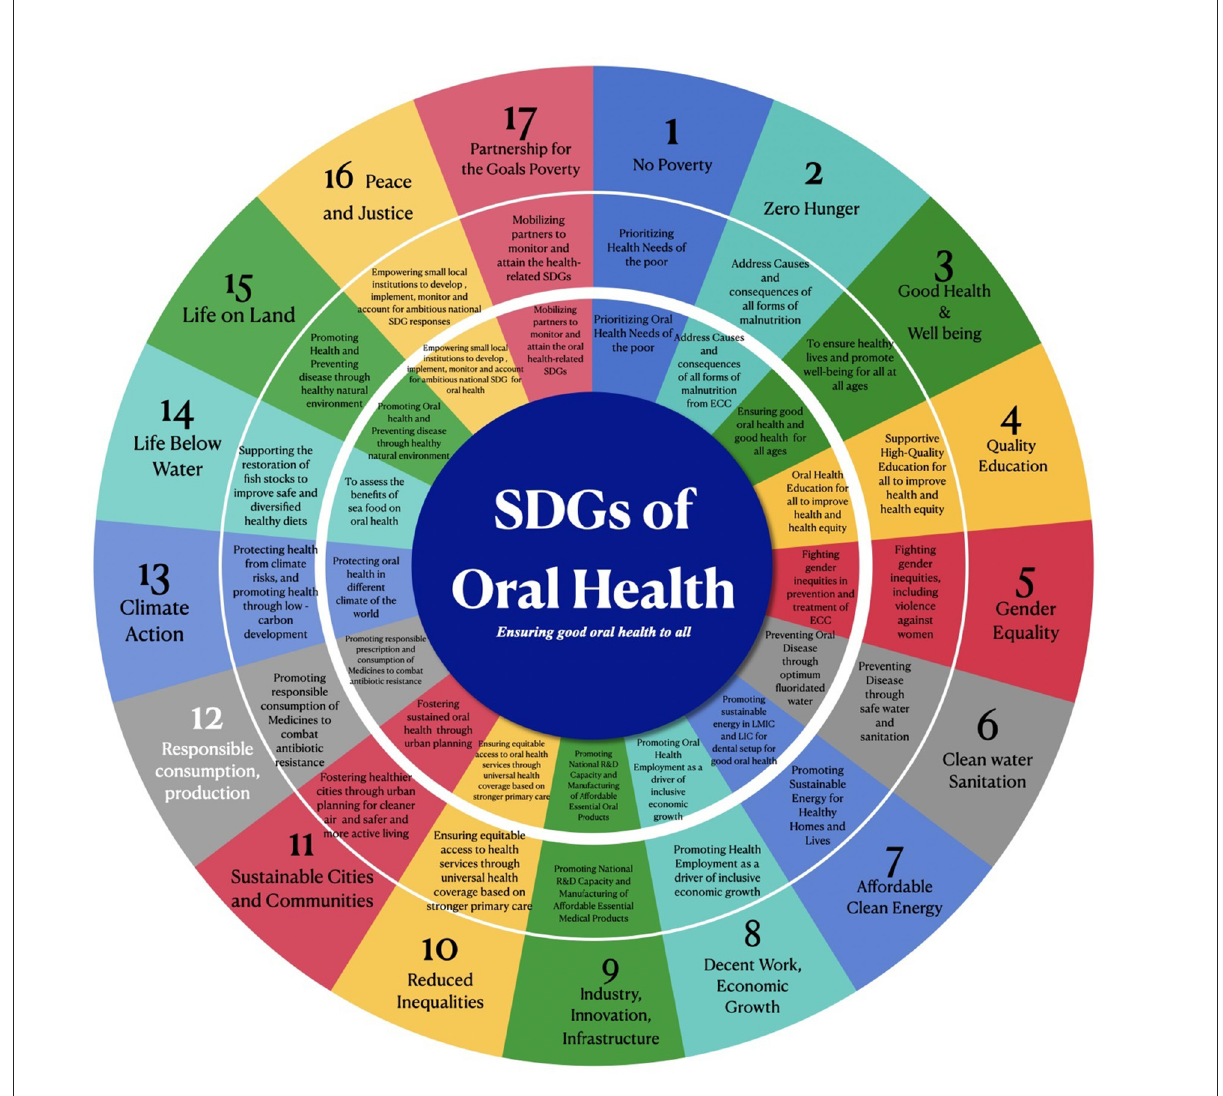
FIGURE3 Illustrates multidisciplinary approaches and possible collaboration with wide range of healthcare